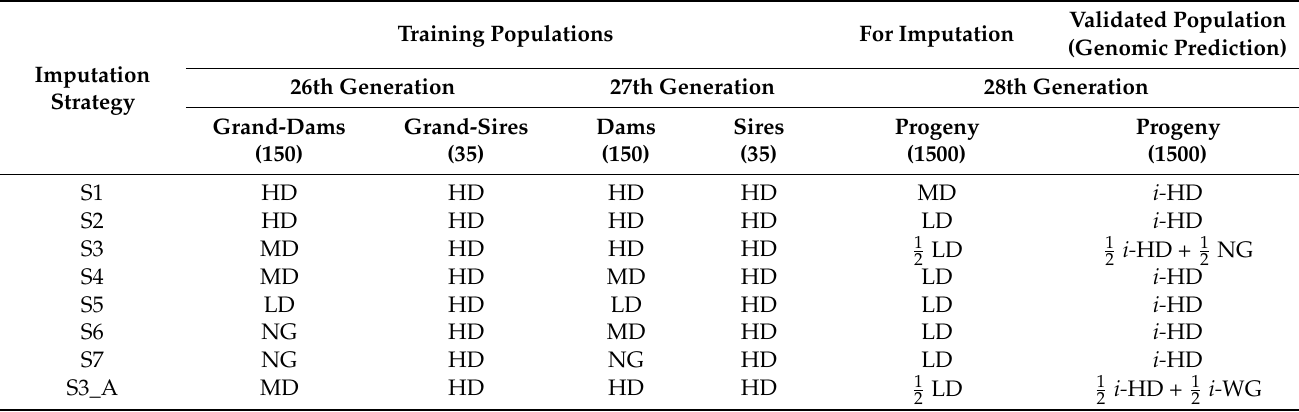
Table 1. Structure of imputation strategies and number of genotyped animals for implementing genomic selection in rabbits.